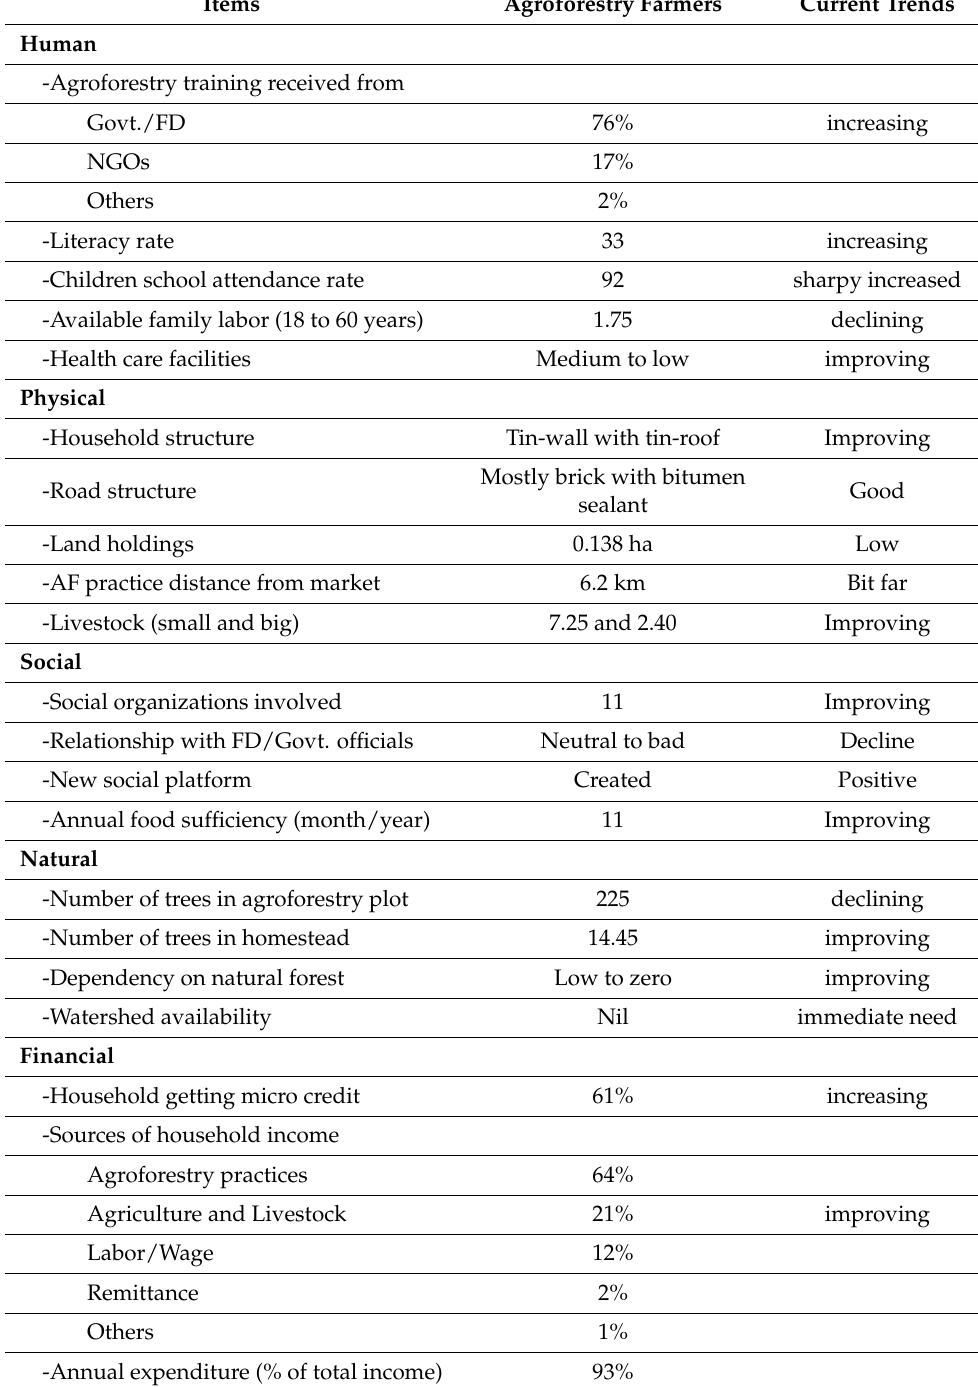
Table 3. Status of major livelihood capitals of Agroforestry farmers.